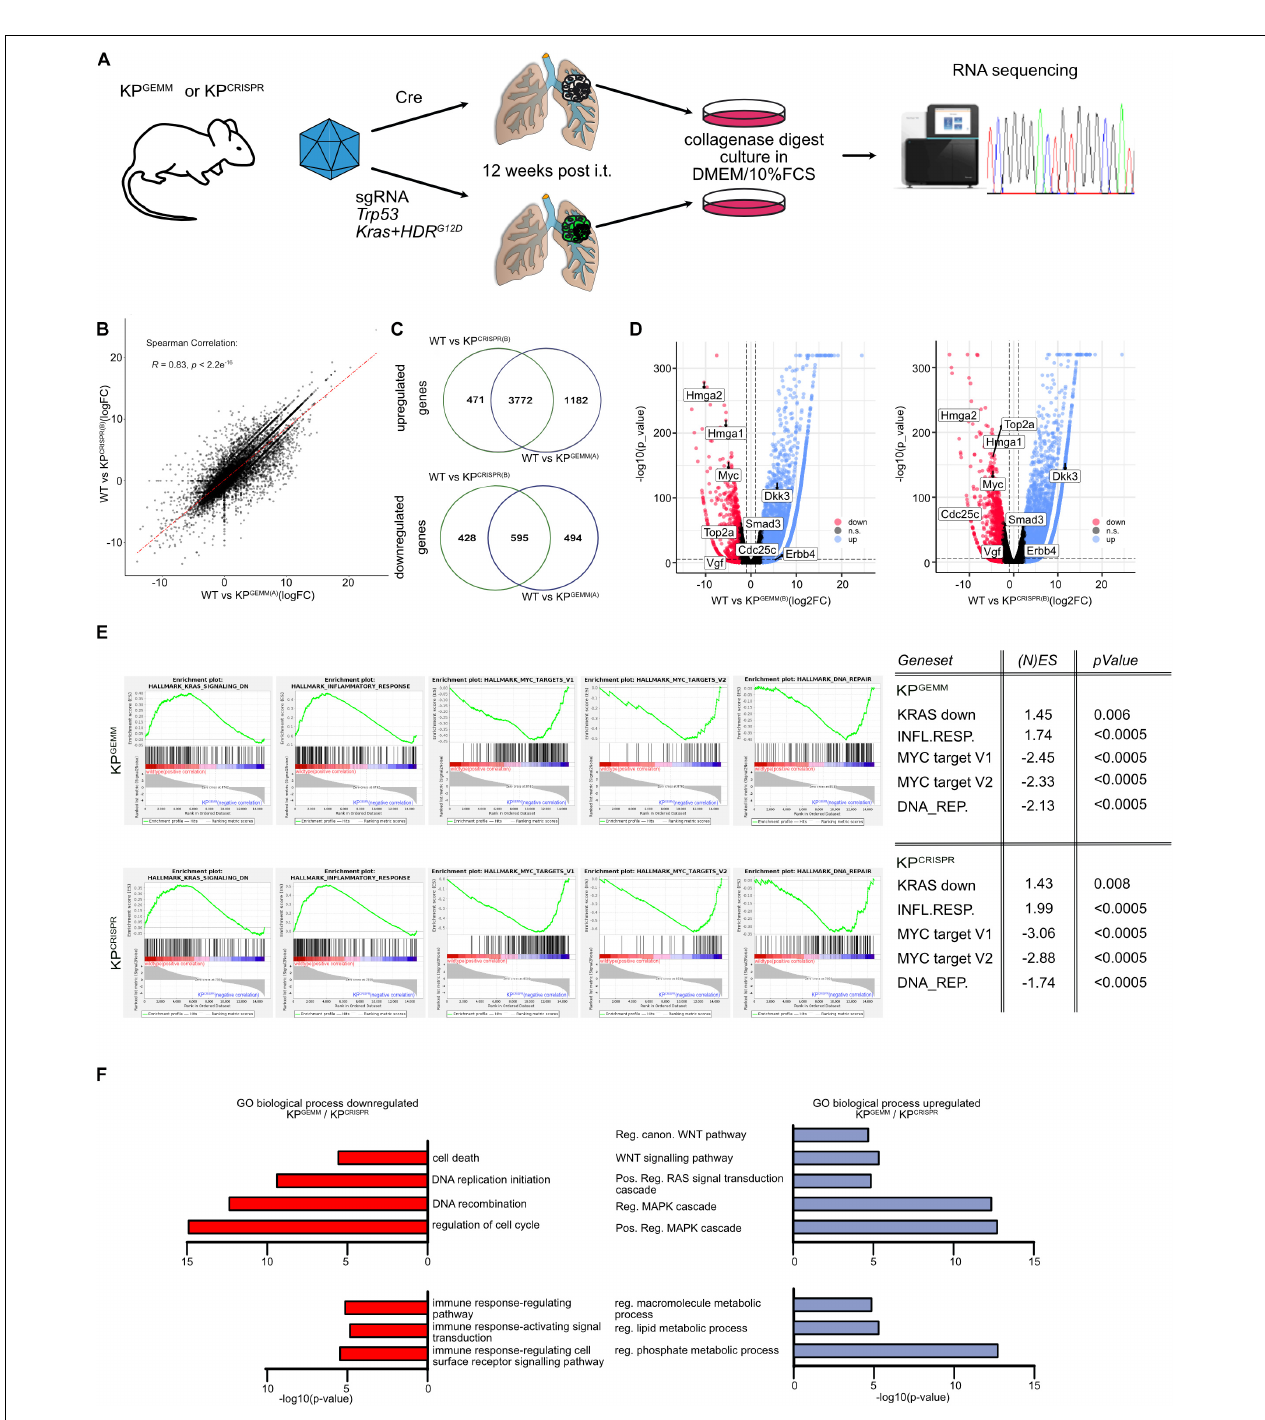
FIGURE 3 | CRISPR-mediated targeting of Trp53 and KRas results in comparable adaptations on the molecular level of tumor cells when compared with KP GEMM . (A) Schematic diagram of the isolation of primary lung tumors from KP GEMM and KP CRISPR , culture, and subsequent RNA-sequencing. (B) Correlation plot of differentially regulated genes in WT versus KP GEMM ( A ) and WT versus KP CRISPR ( A ) . Spearman correlation of R = 0.83, p ≤ 2.2e - 16 . N = 3 each. (C) Venn diagram of individually and commonly up- and downregulated genes between WT versus KP GEMM ( A ) and WT versus KP CRISPR ( A ) . N = 3 each (http://bioinformatics.psb. ugent.be/webtools/Venn/). (D) Volcano plot of genes up- and downregulated in WT versus KP GEMM ( B ) and KP CRISPR ( B ) , respectively. Genes were defined as significant up- and downregulated with log2FC > 2.5. N = 3 each. (E) Gene set enrichment analyses of KRAS, inflammatory response, MYC target genes, and DNA REPAIR target gene expression in KP GEMM and KP CRISPR . (N)ES, normalized enrichment score and p values are depicted in the table. N = 3 each. (F) GO term analysis over biological processes of commonly down- and upregulated genes in KP GEMM ( A ) and KP CRISPR ( A ) , relative to wild-type tissue. N = 3 each. Please also see Supplementary Figure 3